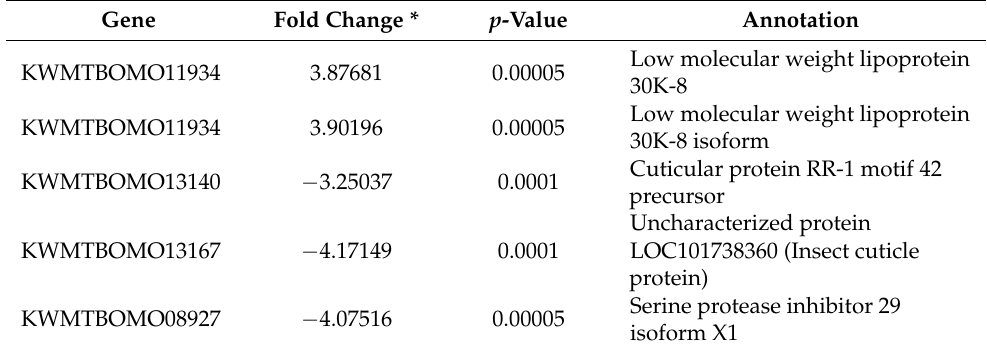
form X1 * Fold change indicates log 2 Fold change. Negative and positive values indicate decreased and increased gene expression by cordycepin injection, respectively.